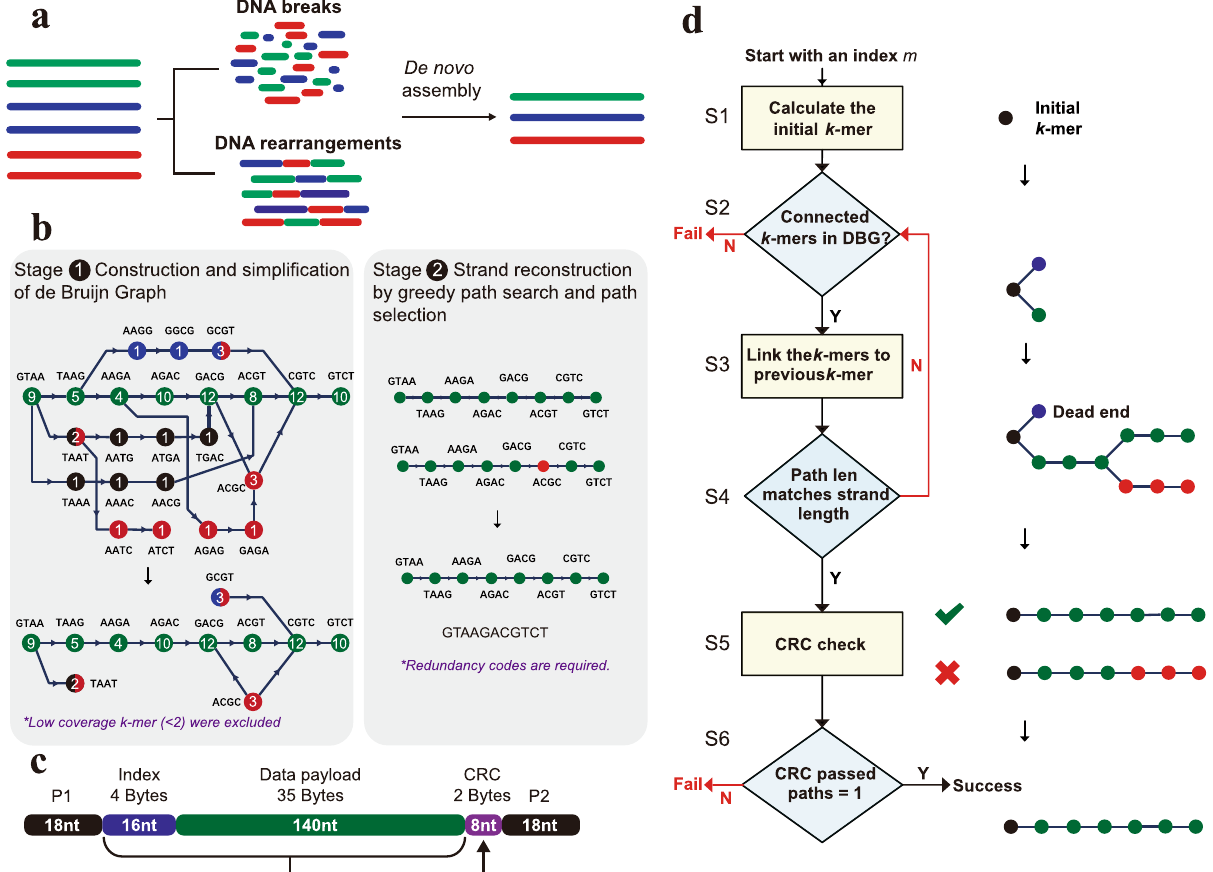
Fig.1|Denovoassembly-basedstrandreconstructionforDNAdatastorage. ( a ) TheissuesofDNAbreaksandrearrangementsinDNAdatastorageandtheproposed de novo assembly-based strategy for dealing with them. ( b ) The two-stage de novo assembly process of the proposed de Bruijn graph-based greedy path search algo- rithm (DBGPS). The representative de Bruijn graph in stage 1 was constructed from